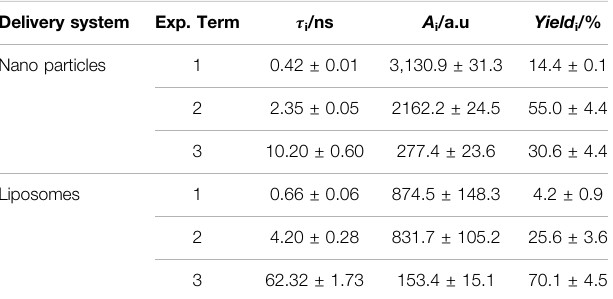
( Figure 5 ) is best fi tted to a sum of three exponential terms ( Table 1 for data). The fi rst sub-nanosecond component is